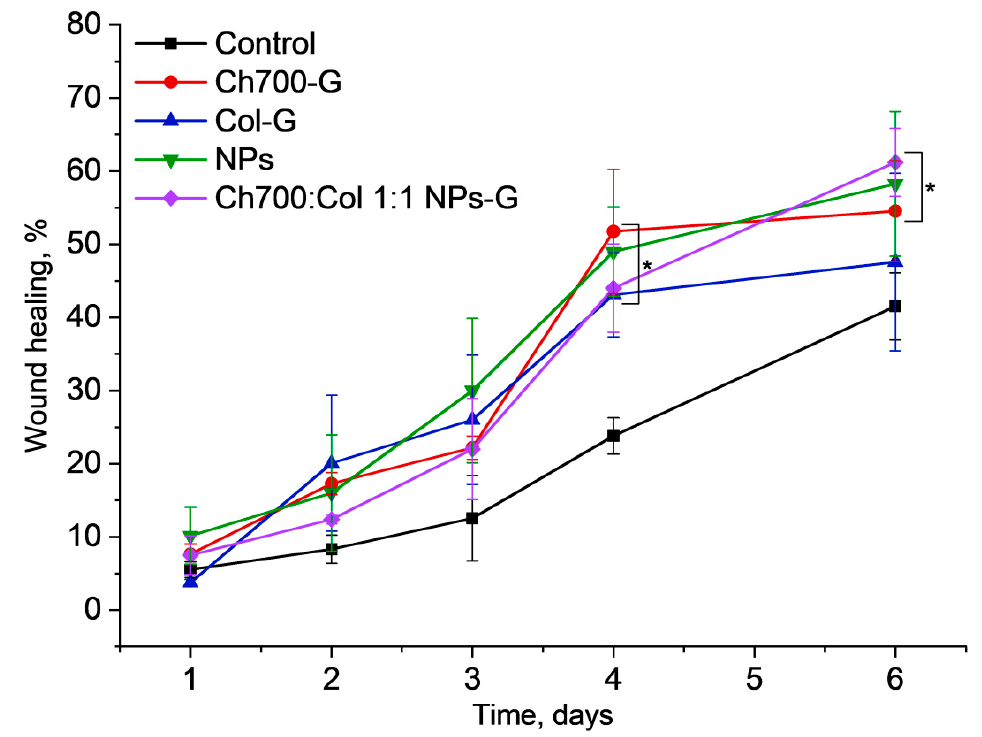
Figure 6. Wound closure without (black curve) or with the gels based on chitosan (Ch700-G), collagen (Col-G), NPs, and Chi700:Col 1:1 NPs-G. The statistical significance was evaluated using the Mann–Whitney test: * p < 0.05 vs. control mice.